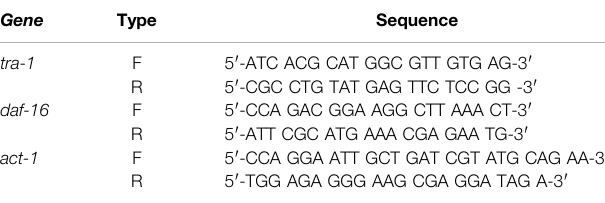
F: forward primer; R: reverse